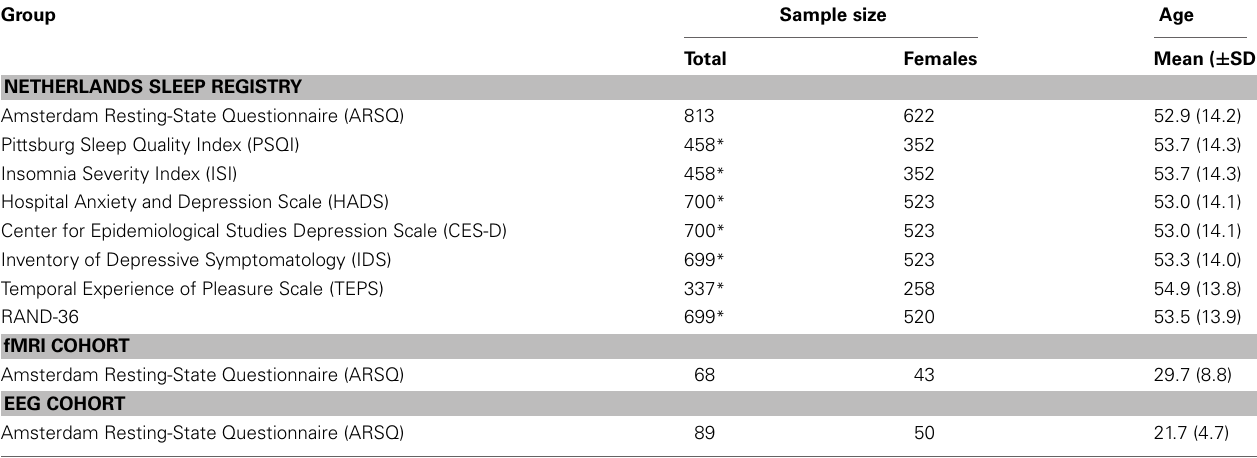
Table 2 | Amsterdam Resting-State Questionnaire participant statistics, based on validated data set ( n = 813).